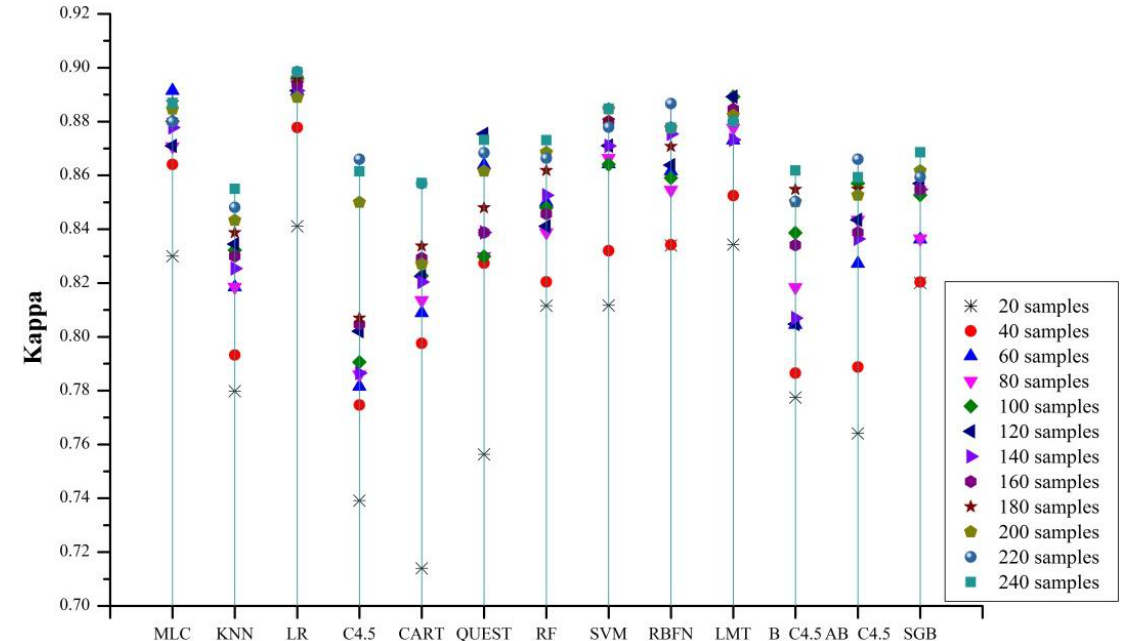
Figure 6. Pixel-based supervised classification with different sizes of training